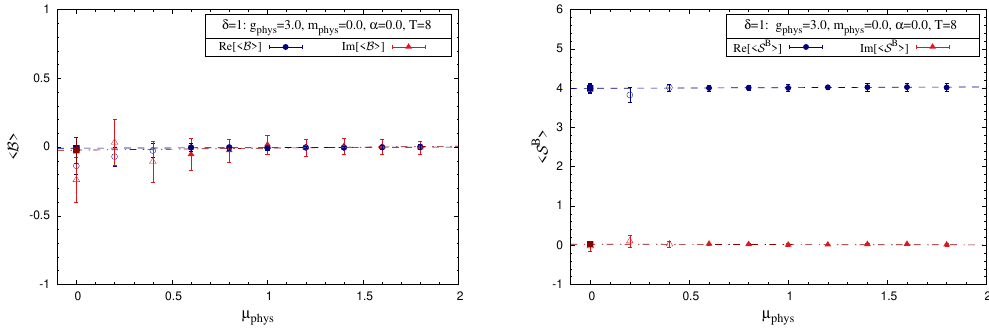
Figure 9 . The δ = 1 model. Expectation values of B α (left) and S B lim µ phys → 0 on a T = 8 lattice. Parameters used in the simulations are g phys = 3 , m phys = 0 , and α = 0